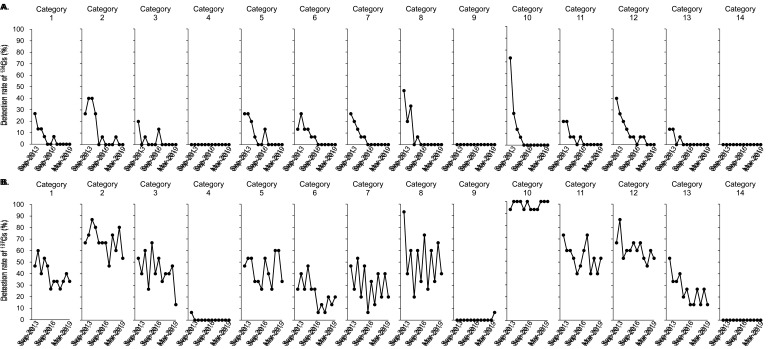
 Time trends of detection rate for r-Cs in each food category. Detection rate for
134Cs and 137Cs in each food category is shown in A and B,
respectively. Data are shown according to the time of study.